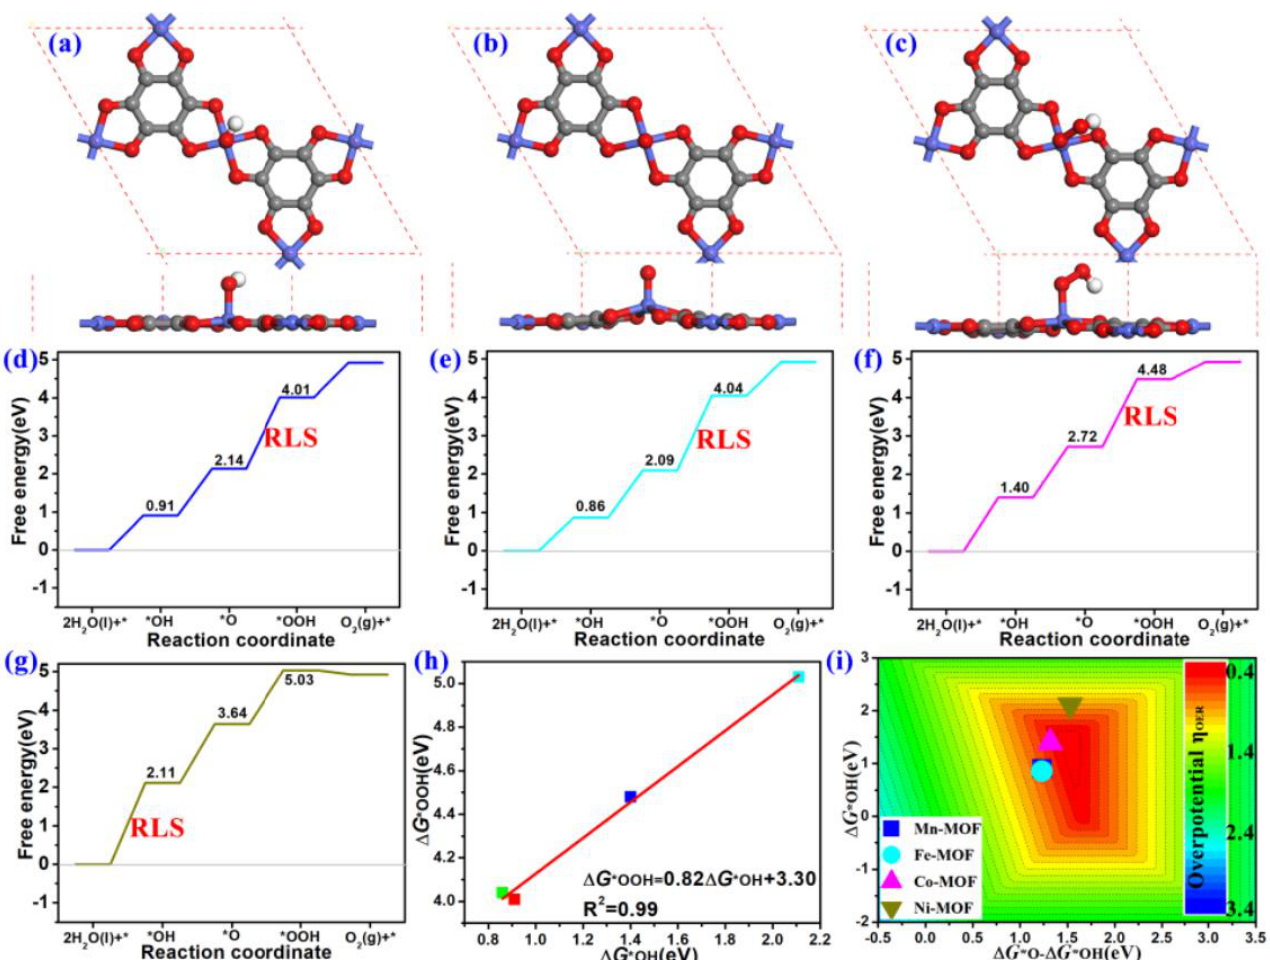
Figure 7. The optimized adsorption configurations of ( a ) *OH, ( b ) *O, and ( c ) *OOH on TM-O MOF. The Gibbs free energy diagram on ( d ) Mn-O MOF, ( e ) Fe-O MOF, ( f ) Co-O MOF, and ( g ) Ni-O MOF. ( h ) Scaling relationship of ∆ G OOH* and ∆ G OH* . ( i ) OER volcano curve displaying the η OER as a function of ∆ G OH* and ∆ G OH* − ∆ G OH* . The units of η OER color bar values are V vs. RHE. Thus, the η OER of Mn-O MOF is 0.64 V. The OER working potential, U work , is defined as U work = η OER + 1.23. (5) Here, the smallest potential suggests the OER is occurring spontaneously. For the Mn-O MOF, the η OER is 0.64 V with a U work of 1.87 V. A similar analysis was carried out for the PLSs of Fe-O MOF and Co-O MOF. Both show that the third step with *O → *OOH is the PLS. Their corresponding ∆ G PLS are 1.95